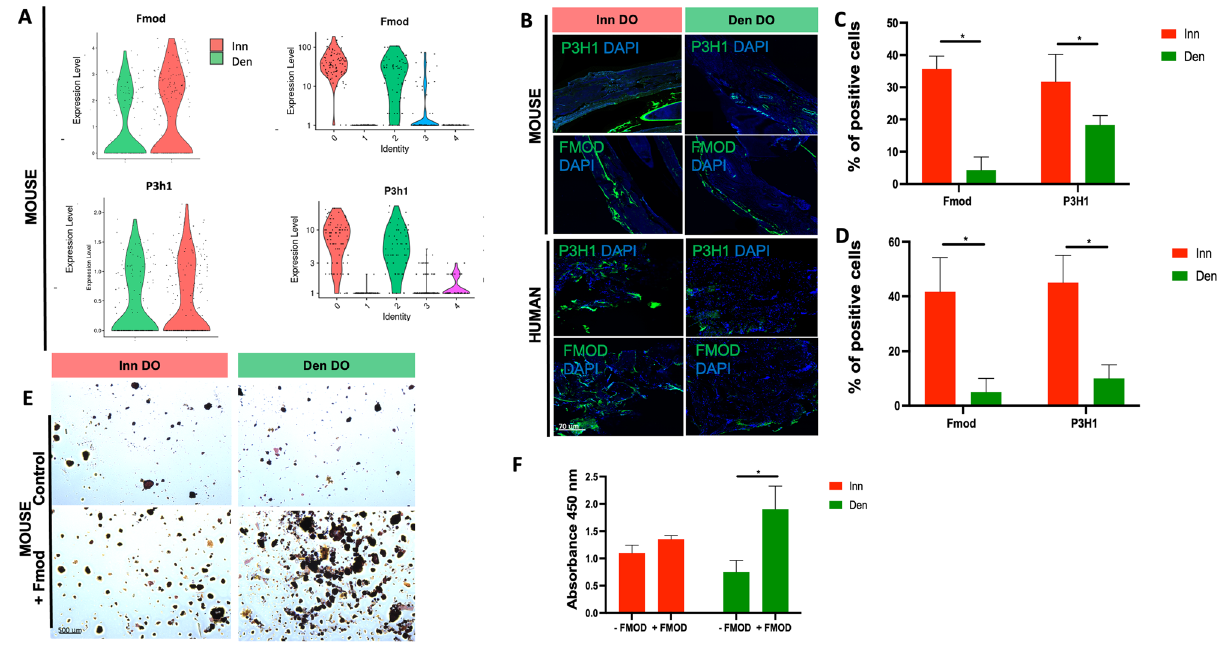
Figure 6. Fibromodulin Expression is Increased in Innervated Distraction and Exogenous Application Improves Osteogenic Potential In Vitro In Den DO. ( A ) Violin plots of FMOD and P3H1 in (left) Inn DO and Den DO mSSCs and (right) mSSC pro-osteogenic clusters. ( B ) Immunohistochemistry (IHC) analysis of P3H1 and Fmod expression Inn DO and Den DO human (bottom) and mouse (top) tissue specimens. (Blue, DAPI). (n = 3). ( C ) Quantification of FMOD (left) and P3H1 (right) IHC staining of mouse specimens. Red = Inn DO mSSC, green = Den DO mSSC. ( D ) Quantification of FMOD (left) and P3H1 (right) IHC staining of human specimens. Red = Inn DO mSSC, green = Den DO mSSC. ( E ) Alizarin red staining of Fmod treated Den Do and Inn DO mSSCs at postoperative day 14. ( F ) Graph demonstrating quantification of alizarin red staining following Fmod treatment (−FMOD = control, +FMOD = treatment group). p * < 0.05. Red = Inn DO mSSC, green = Den DO mSSC. (n =